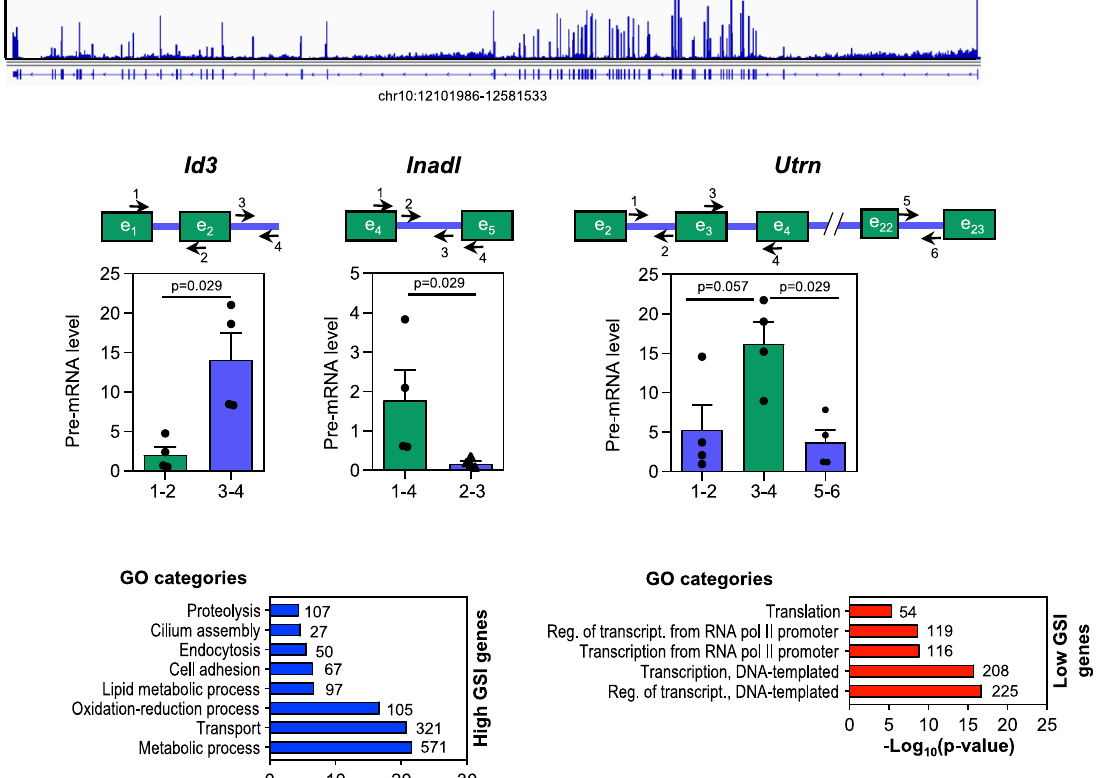
Fig. 2 Gene splicing ef fi ciency. a Schematics outlining the approach used to measure the Gene Splicing Index (GSI). RPKM, reads per kilobase per million mapped reads. b GSI values ordered from low to high GSI and binned into ten deciles. Low-GSI genes (i.e., genes in the fi rst decile) are indicated in red, and high- GSI genes (i.e., genes in the last decile), in blue. Student ’ s t -test p -values of the indicated comparison are shown. c Chromatin-associated RNA-seq (ChrRNA-seq) IGV snapshots are shown for genes with a low GSI ( Id3 and Tbpl1 ) or a high GSI ( Inadl and Utrn ). d RT-qPCR determination of intronic and exonic levels of one low- GSI gene ( Id3 ) and two high-GSI genes ( Inadl and Utrn ) using chromatin-associated RNA. Represented values are mean±SEM of four ( n = 4) independent biological replicates. Unpaired two-tailed Mann – Whitney p -values of the indicated comparison are provided. e Functional analysis using Gene Ontology (GO) of high-GSI genes and low-GSI genes. Number of genes in each category is shown. Sample size ( n ) of all sets of data are provided in Supplementary Data